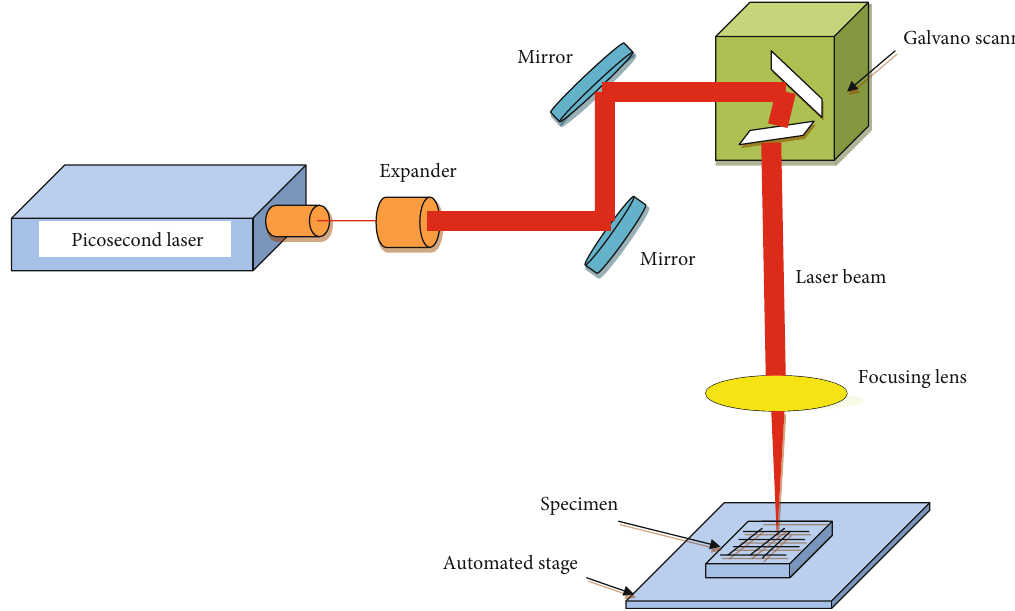
Figure 2: Schematic representation of the picosecond laser surface processing facility. Table 1: Dimensions of modi fi ed